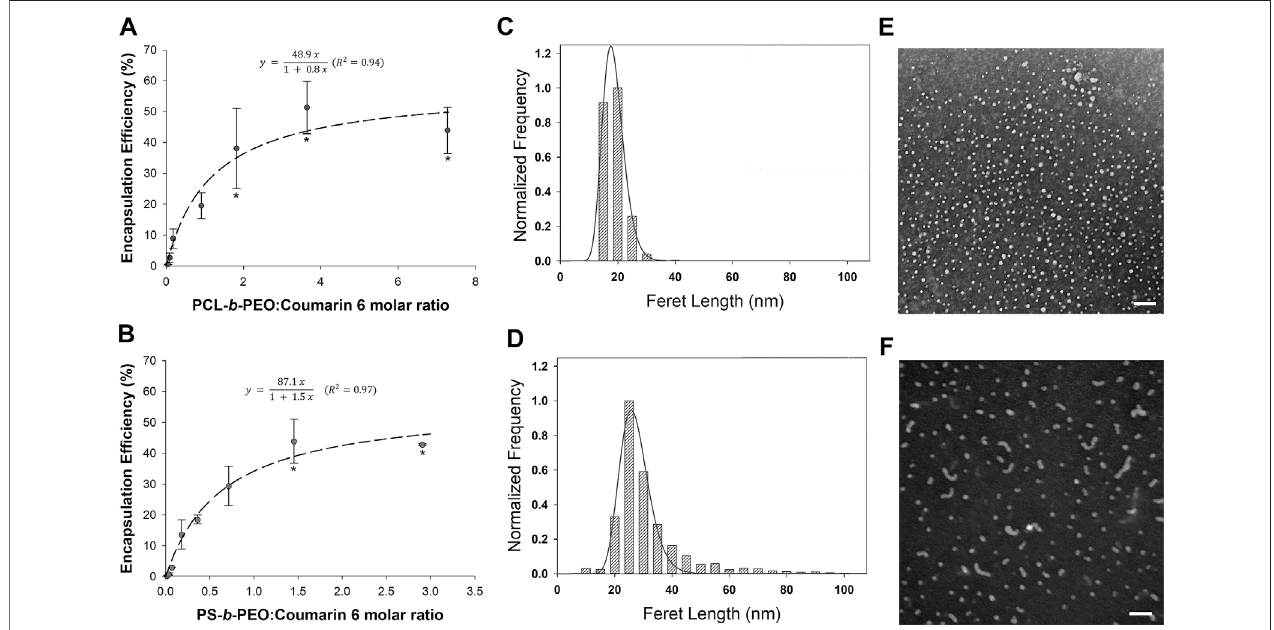
FIGURE7| Coumarin6encapsulationef fi ciency(%)in (A) PCL- b -PEOand (B) PS- b -PEOnanocarrierssynthesizedusingEM-NPatvaryingBCPtoCoumarin6 M ratio.Errorbars (cid:1) standard deviationfrommean.Experimentalrunsat eachdatapoint, n (cid:1) 2.Starsineach frameindicate nostatistical difference. (C,D) Sizedistribution and log normal fi ts and (E,F) corresponding TEM images for coumarin 6 loaded (C,E) PCL- b -PEO NPs (polymer:drug molar ratio (cid:1) 3.64) and (D,F) PS- b -PEO NPs (polymer:drug molar ratio (cid:1) 1.45) synthesized using EM-NP. TEM Scale bar (cid:1) 100 nm.